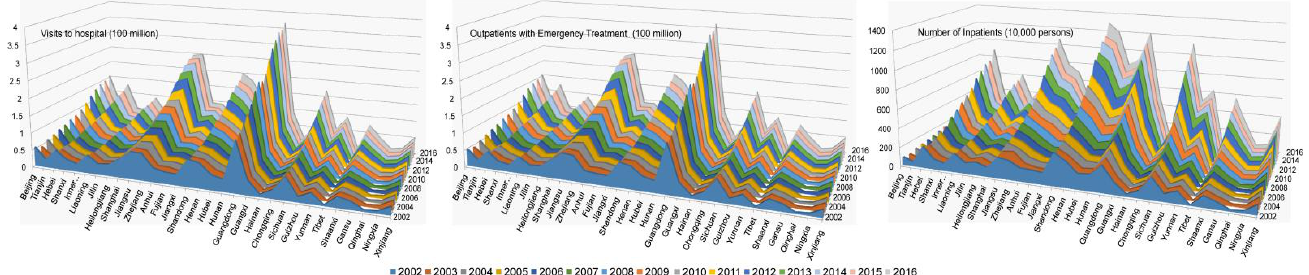
Figure 1. Main indicators for RHC in China.